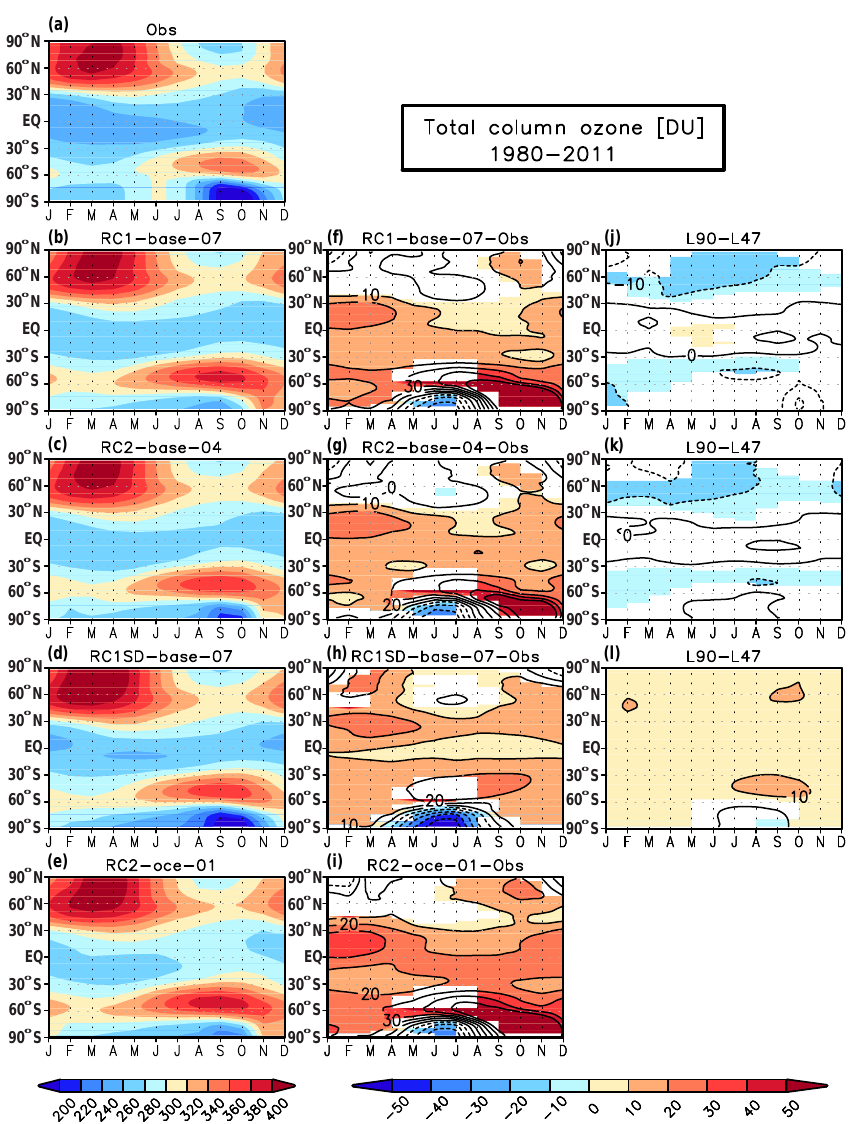
Figure 27. Left column (a–e) : climatological annual cycle of total column ozone (1980–2011, in DU) from BSTCO observations (a) and selected simulations (RC1-base-07: b ; RC2-base-04: c ; RC1SD-base-07: d ; RC2-oce-01: e ). Middle column (f–i) : difference between the simulations and the BSTCO observations (in DU). Right column (j–l) : difference (in DU) between the corresponding simulations with high (b–e) and low vertical resolution (RC1-base-08: j ; RC2-base-05: k ; RC1SD-base-08: l ). Statistical significance is tested with the paired t test. Statistically significant changes on the 95% confidence level are